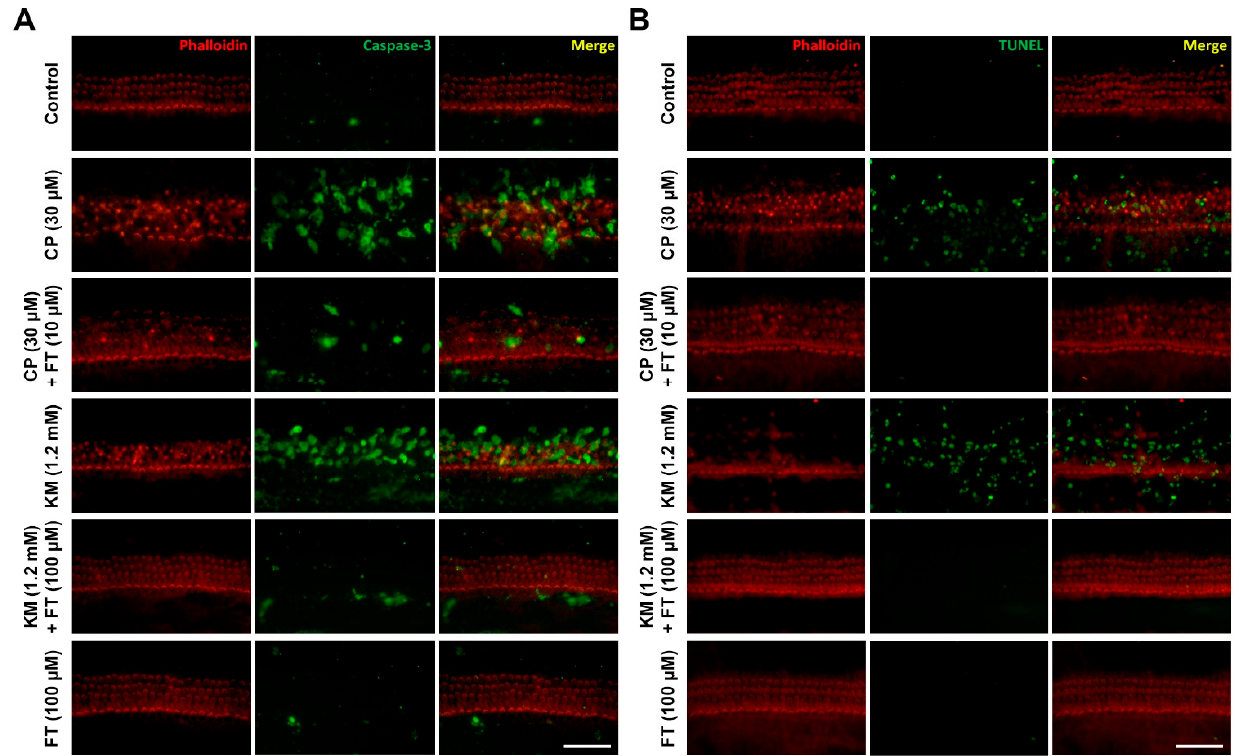
Figure 2. Effect of FT on CP- and KM-induced apoptosis of hair cells. Apoptosis and DNA damage were detected by ( A ) anti-active caspase-3 and ( B ) TUNEL assays, respectively, in Control, CP, CP + FT, KM, KM + FT, and FT groups ( n = 9, each). Images were acquired from the mid region of the organ of Corti. Phalloidin (red) and active caspase-3 or TUNEL (green). A total of 30 mice were used in each experiment. CP: cisplatin, KM: kanamycin, FT: fursultiamine. Scale bar, 50 µm.